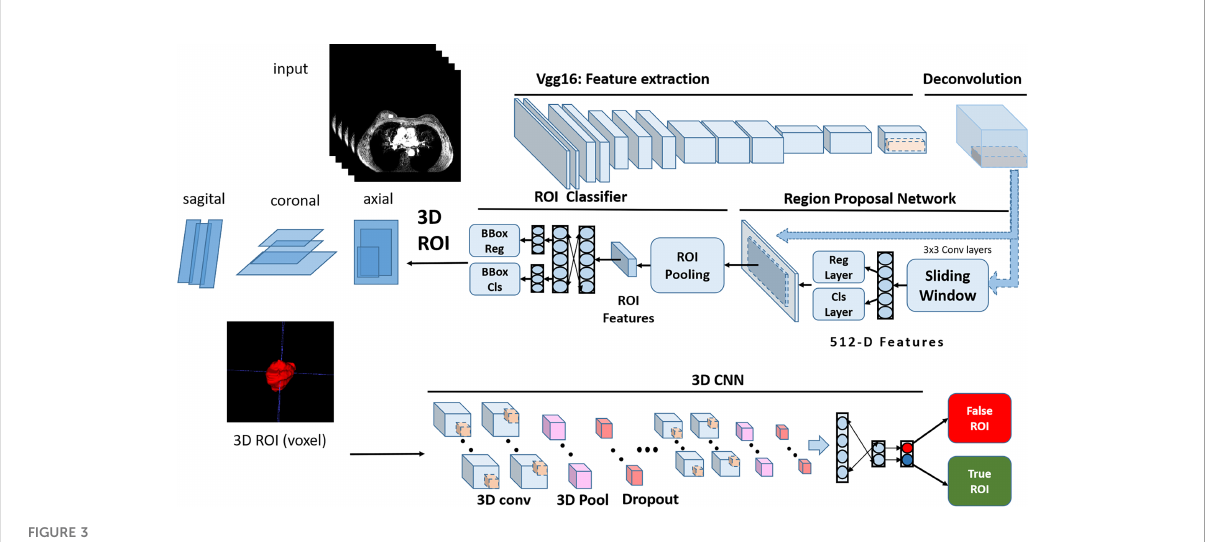
FIGURE 3 The network architecture of Faster R-CNN for ROI localization.